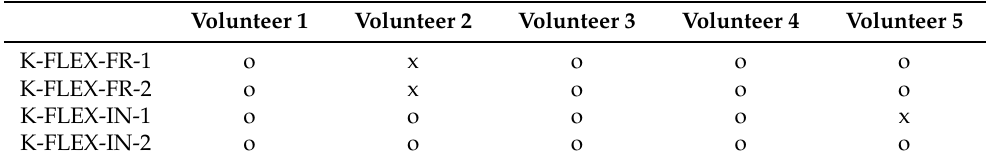
Table 3. Table of recorded movements, explaining which ones were not analyzed, identified by “o” for the positive ones and “x” for the negative